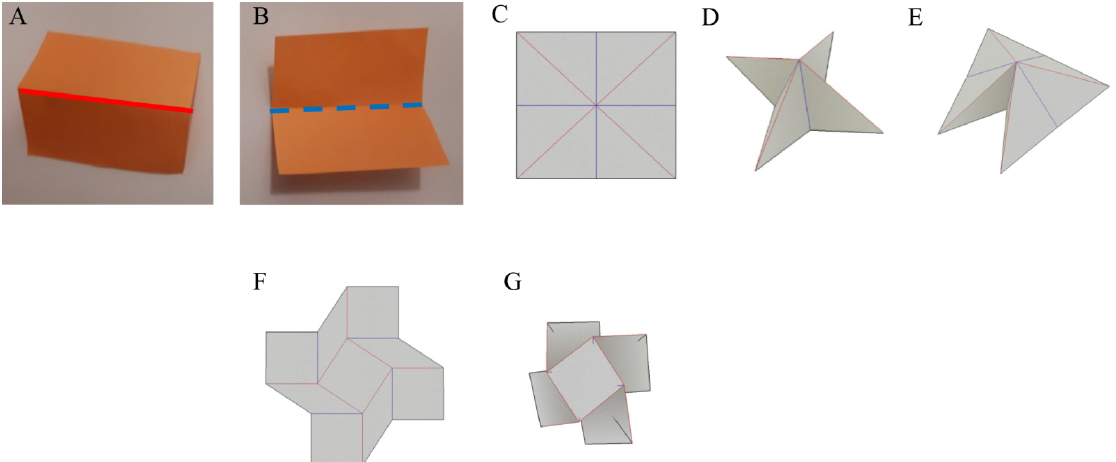
Figure 3. Folding variations and concepts in origami models. Folding variation: ( A ) mountain fold, and ( B ) valley fold. The "double square" origami model with several stable states: ( C ) unfolded model, where the mountains in the crease pattern are marked in blue and the valleys in red, ( D ) a model that is folded from the crease pattern ( E ) a second folded stable state of the origami model. A “square twist” origami model, which is often incorporated in origami tessellation models, with only two stable states: ( F ) unfolded model, and ( G ) folded model (simulated in Freeform Origami software [27]). The model folds synchronically from unfolded to folded